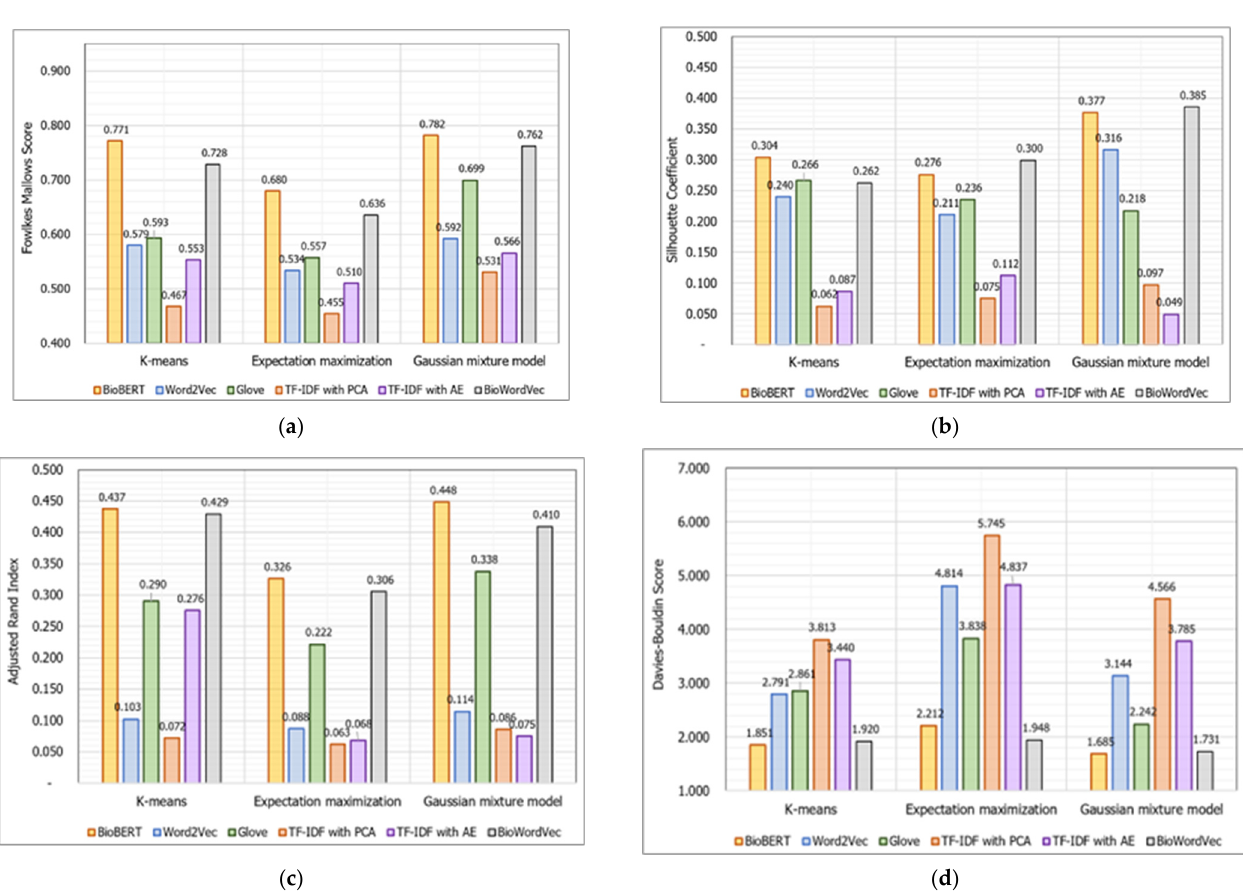
Figure 6. Comparison charts of the biomedical document clustering models based on different evaluation metrics: ( a ) Fowlkes–Mallows score, ( b ) silhouette coefficient, ( c ) adjusted Rand index, ( d ) Davies–Bouldin score.